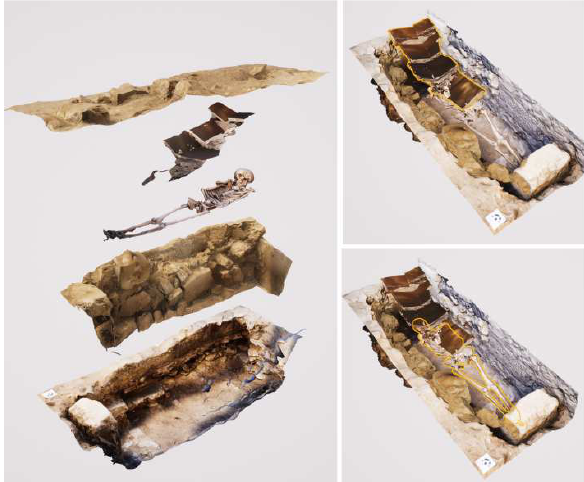
Figure 4. Digital model with the stratigraphic units that make up the tomb: figure exported to Abvent Twinmotion software. On the skeletons, all in primary positioning, the anatomical connections were very loose or disconnected with the location of several districts; furthermore, there were clear signs of side rotations of the femurs, with the patellas also found in non- anatomical positions, loss of original thoracic volumes and the sliding of the sternum inside it. There were instances of ‘wall effect’, that is the alignment of several bones caused by the line border of the grave itself.